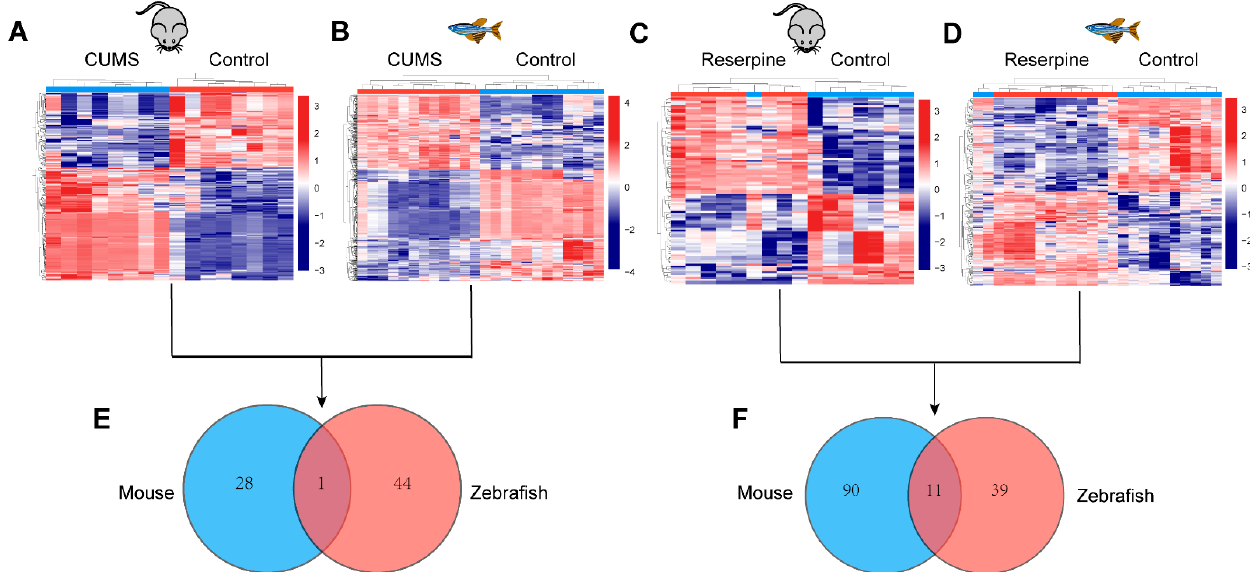
Figure 4. The heatmap and Venn diagram of each model. ( A ) The heatmap of CUMS in mice. ( B ) The heatmap of CUMS in zebrafish. ( C ) The heatmap of reserpine in mice. ( D ) The heatmap of reserpine in zebrafish. ( E ) Venn diagram of differential metabolites that were in common with or unique to the CUMS models in mice and zebrafish. ( F ) Venn diagram of differential metabolites that were in common with or unique to the reserpine models in mice and zebrafish. In ( A – D ), Blue represents Control group, red represents model group.